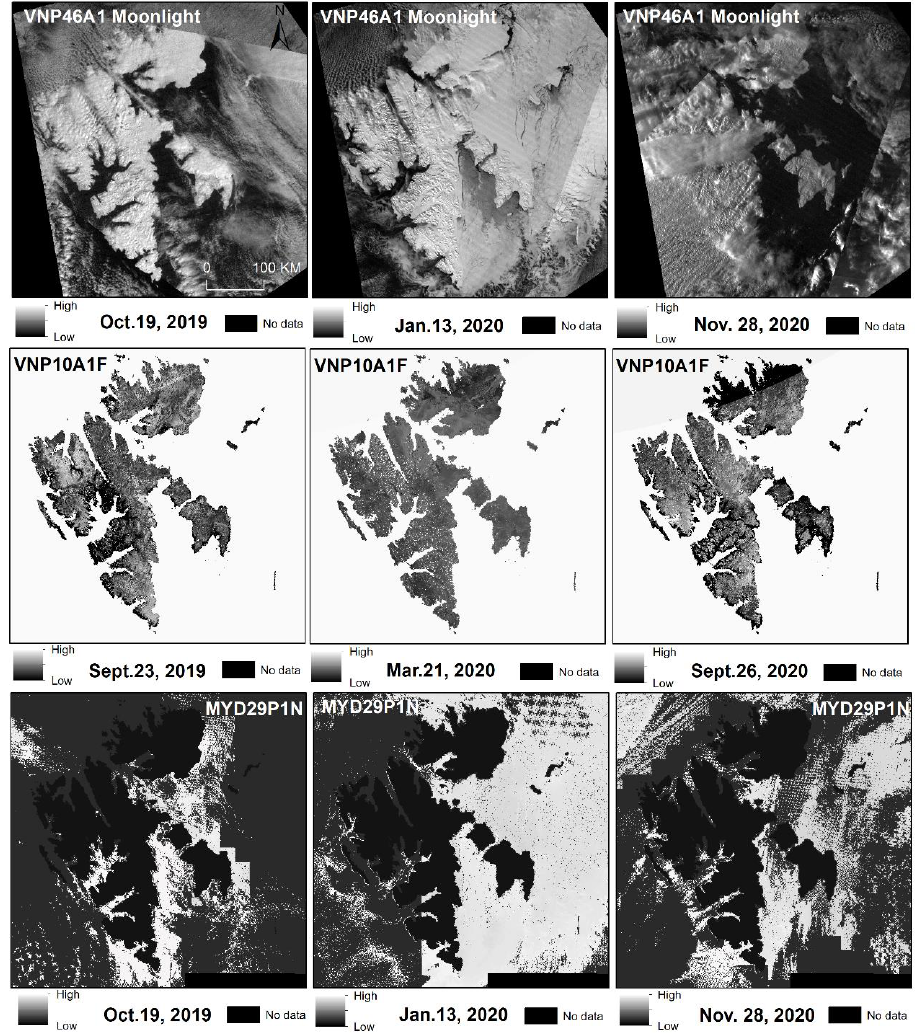
Figure 14. VNP46A1 moonlight images, and VNP10A1F and MDY29P1N optical remote sensing snow/ice products during 2019 – 2020.